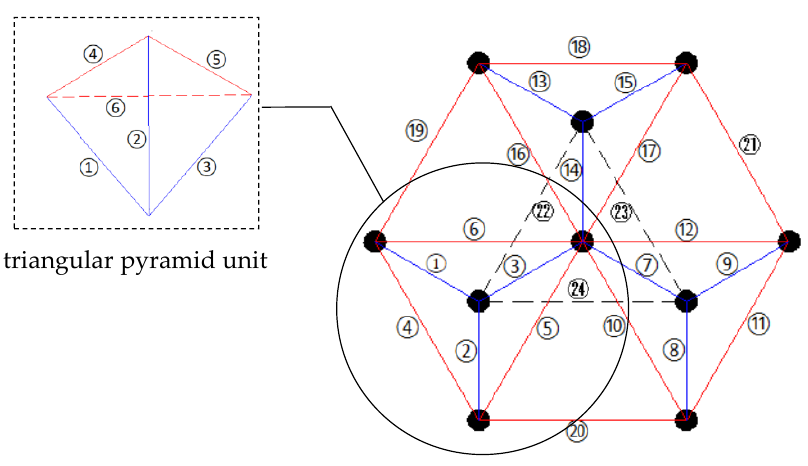
Figure 4. Photo of triangle-on-triangle offset grid model.